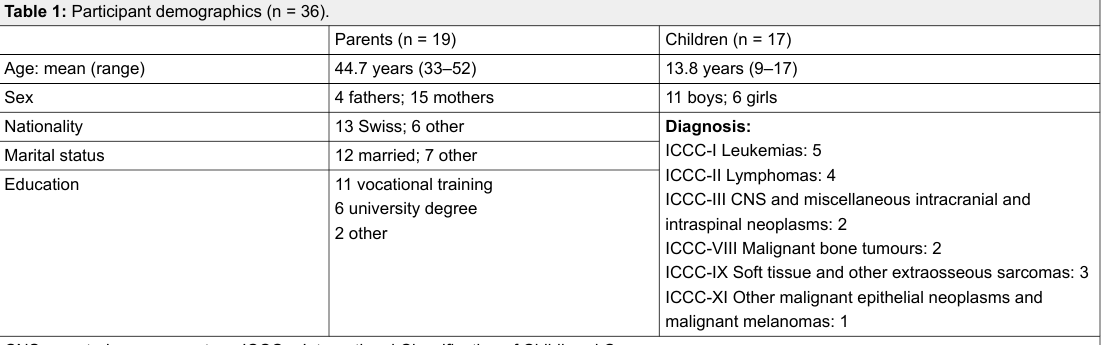
Table 1: Participant demographics (n =